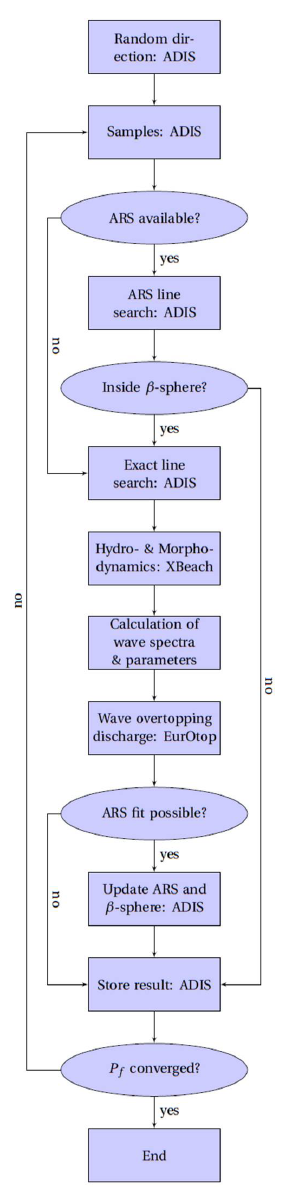
Figure 4. Model framework, using ADIS, XBeach and EurOtop to calculate the probability of dike failure due to wave overtopping.